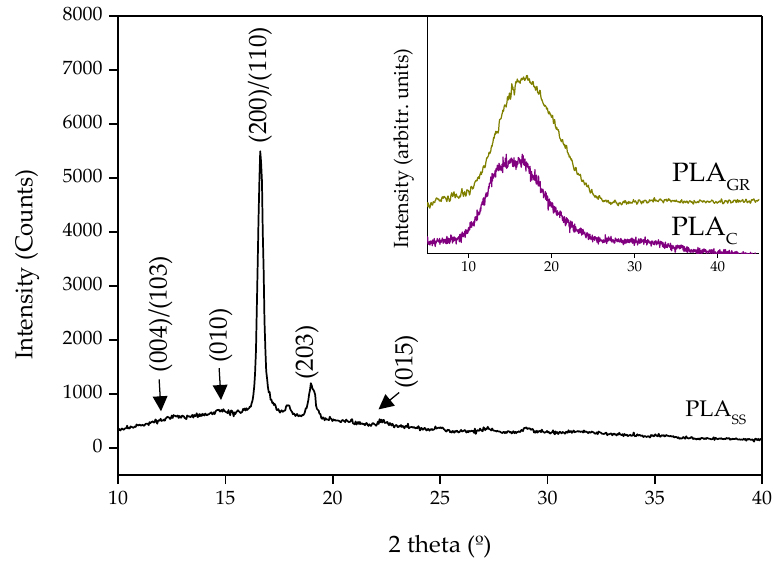
Figure 5. XRD diffraction pattern of untreated PLA SS with the identification of the characteristic peaks and PLA C , and PLA GR diffraction pattern at the inset.